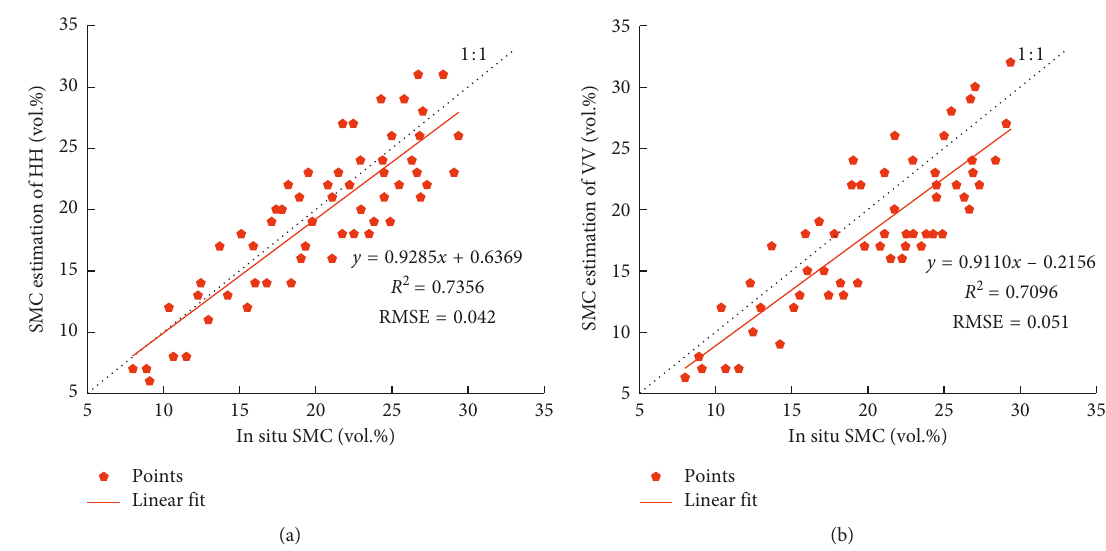
Figure 9: (a, b) Scatter diagram between in situ soil moisture and retrieved soil moisture.